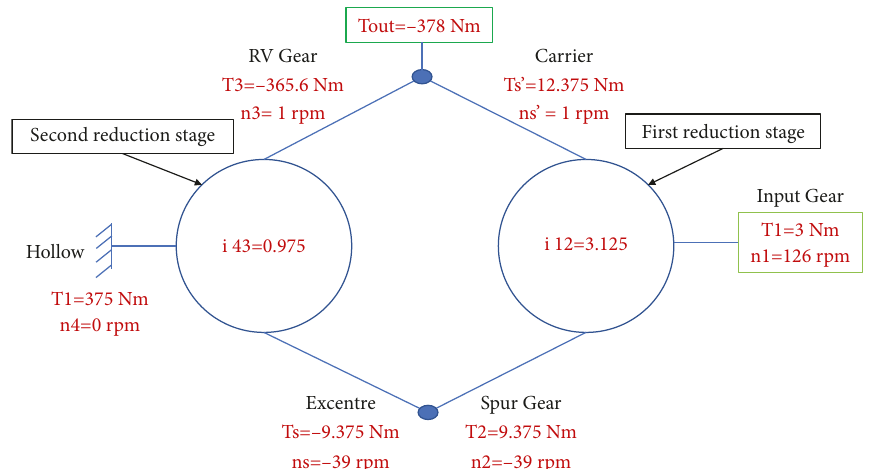
i 12=3.125i 43=0.975